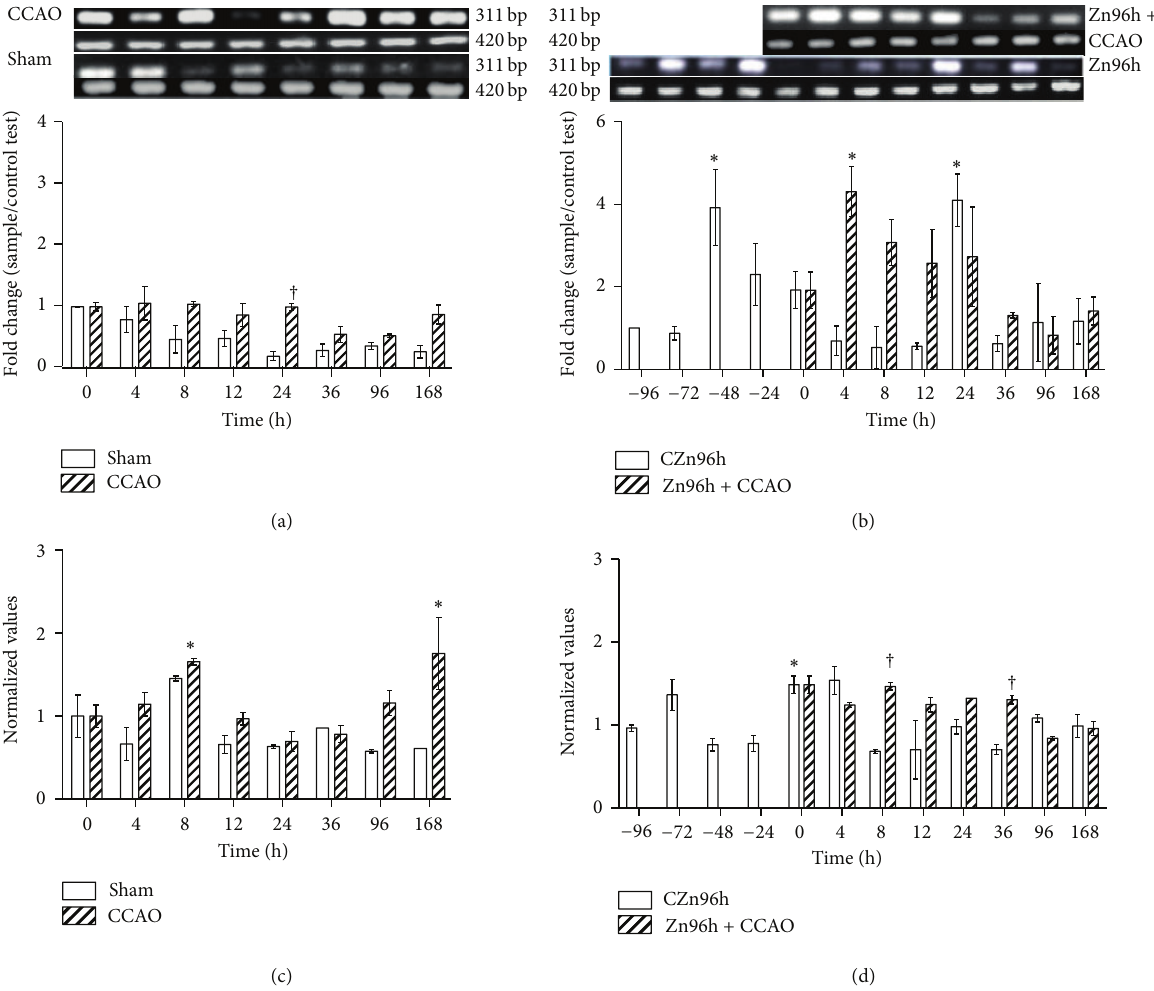
Figure 2: The subacute administration effect of zinc on levels of CCR2 expression after hypoxia-ischemia in rats. RT-PCR was used to determine mRNA levels of CCR2 (311bp) and GA3PDH (420bp). ((a) and (b)) Showing representative photographs of ethidium-bromide- stained RT-PCR products fractionated on 2% agarose gel and the respective densitometry analysis. ((c) and (d)) Showing the CCR2 protein levels measured using ELISA. Each value represents the mean ± SEM of 5 independent experiments in triplicate. (1) Zn96h, rats injected with ZnCl 2 (one dose every 24 h during 4 days). (2) Zn96h + CCAO, rats treated with zinc before 10min of common carotid artery occlusion (CCAO). (3) CCAO, rats with CCAO only. (4) Sham group, rats with mock CCAO. (5) Untreated rats. ∗ , significant when compared with